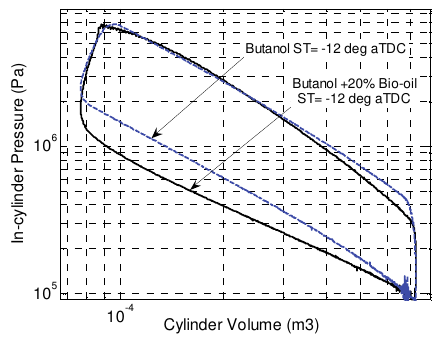
Fig. 11. In-cylinder pressure profile as a function of the cylinder